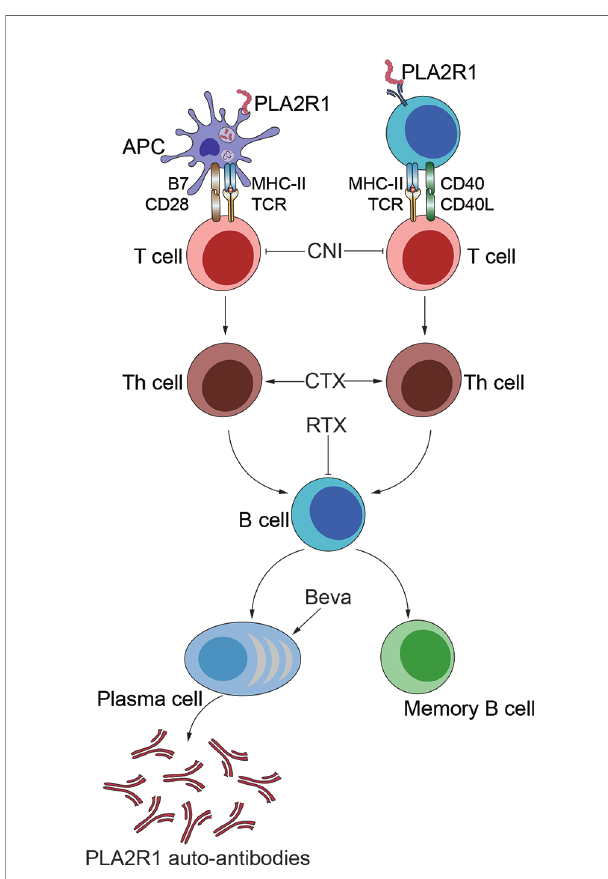
FIGURE 2 | Target of drug action. The targets of immunosuppressive agents are different links in the immune